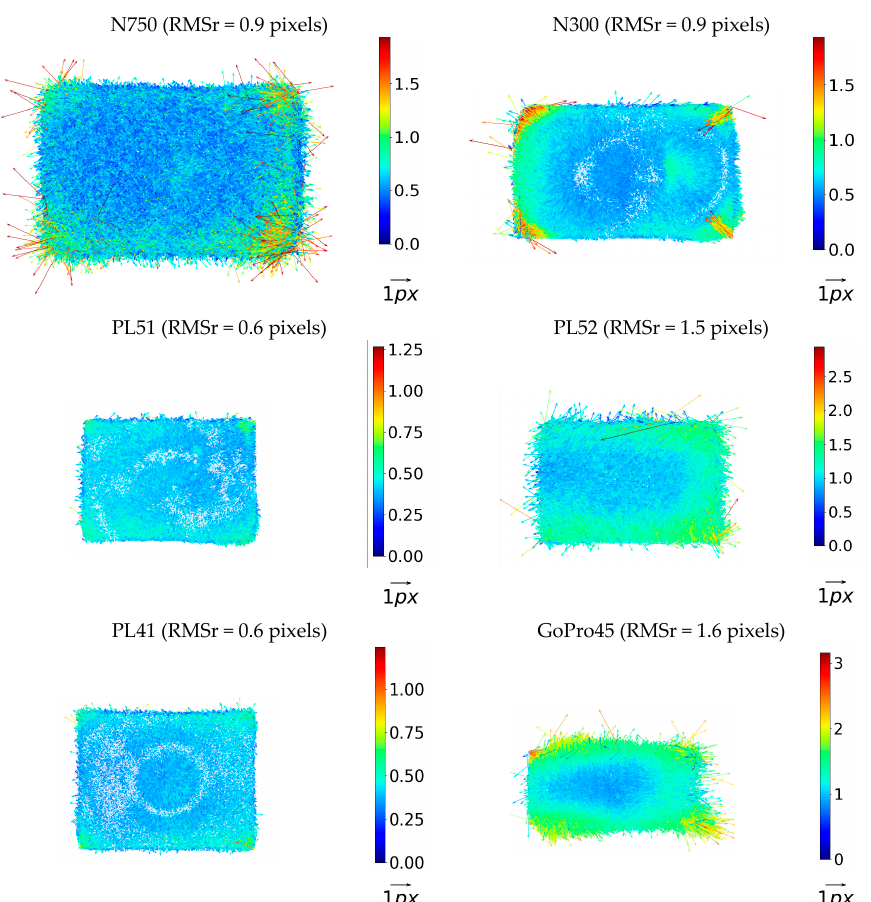
Figure 12. Average image residual patterns at 2 m working distance with the root mean square (RMS) reprojection error (r).